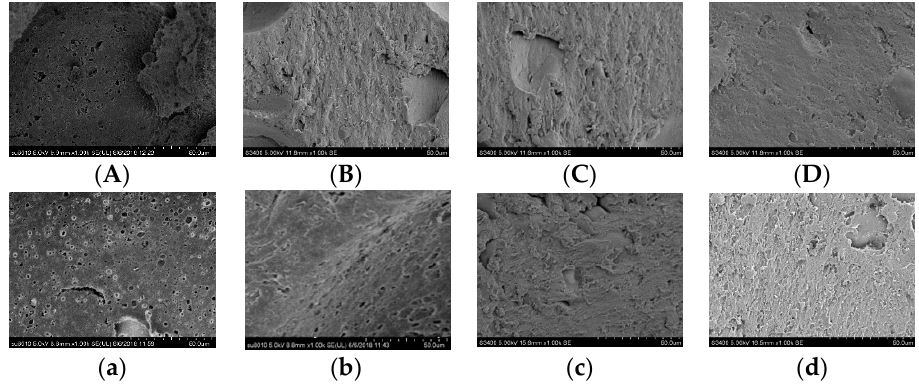
Figure 6. Scanning electron microscopy of heat- and cold-induced gels with 1000× magnification: ( A ) Cold-induced control gels; ( B ) Cold-induced gels with Na + (0.01 M); ( C ) Cold-induced gels with Mg 2+ (0.005 M); ( D ) Cold-induced gels with Ca 2+ (0.005 M); ( a ) Heat-induced control gels; ( b ) Heat-induced gels with Na + (0.01 M); ( c ) Heat-induced gels with Mg 2+ (0.005 M); ( d ) Heat-induced gels with Ca 2+ (0.005 M).